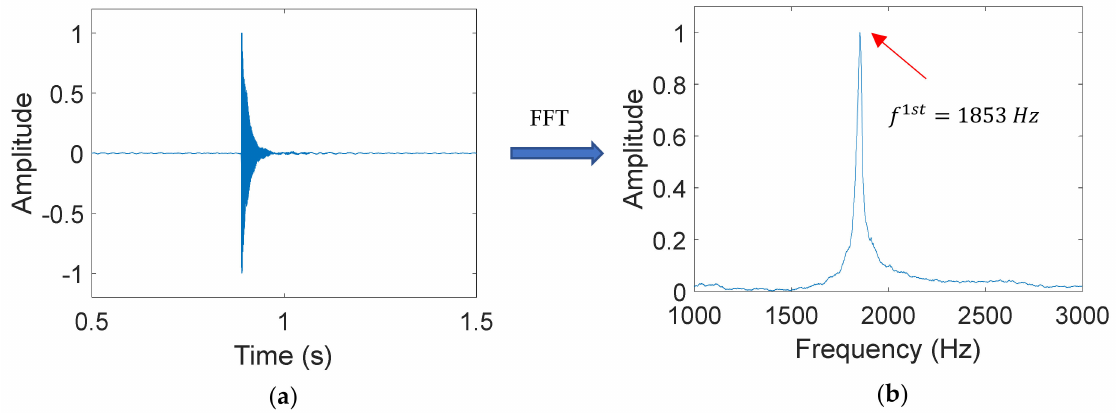
Figure 11. Example of extracting resonant frequency ( a ) Vibration signal generated by hammer impact ( b ) Frequency spectrum obtained via